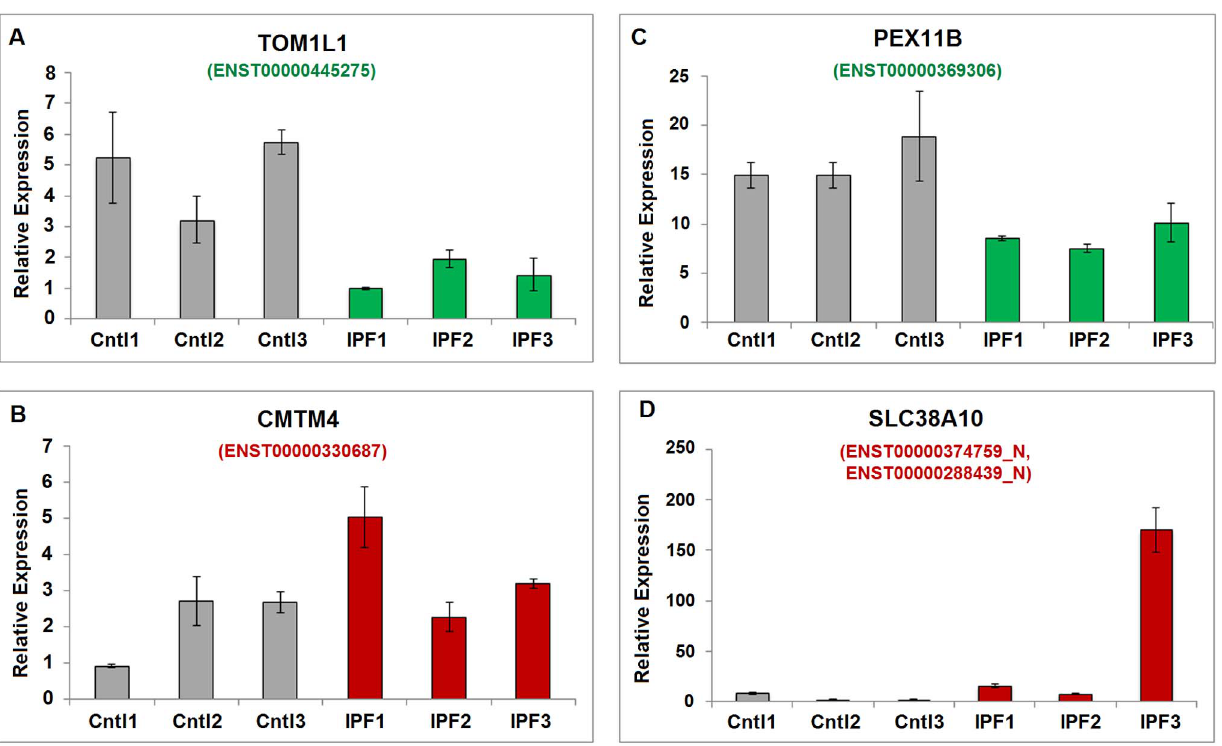
Figure 6. The qRT-PCR validation results for the annotated transcripts and the novel transcripts. (A) The validation result for the down- regulated (in green color) isoform ENST0000445275 of gene TOM1L1. (B) The validation result for the up-regulated (in red color) isoform ENST0000330687 of gene CMTM4. (C) The validation result for the down-regulated (in green color) isoform ENST0000369306 of gene PEX11B. (D) The validation result for the mixture of up-regulated (in red color) novel transcripts ENST00000374759_N and ENST00000288439_N of gene SLC38A10.